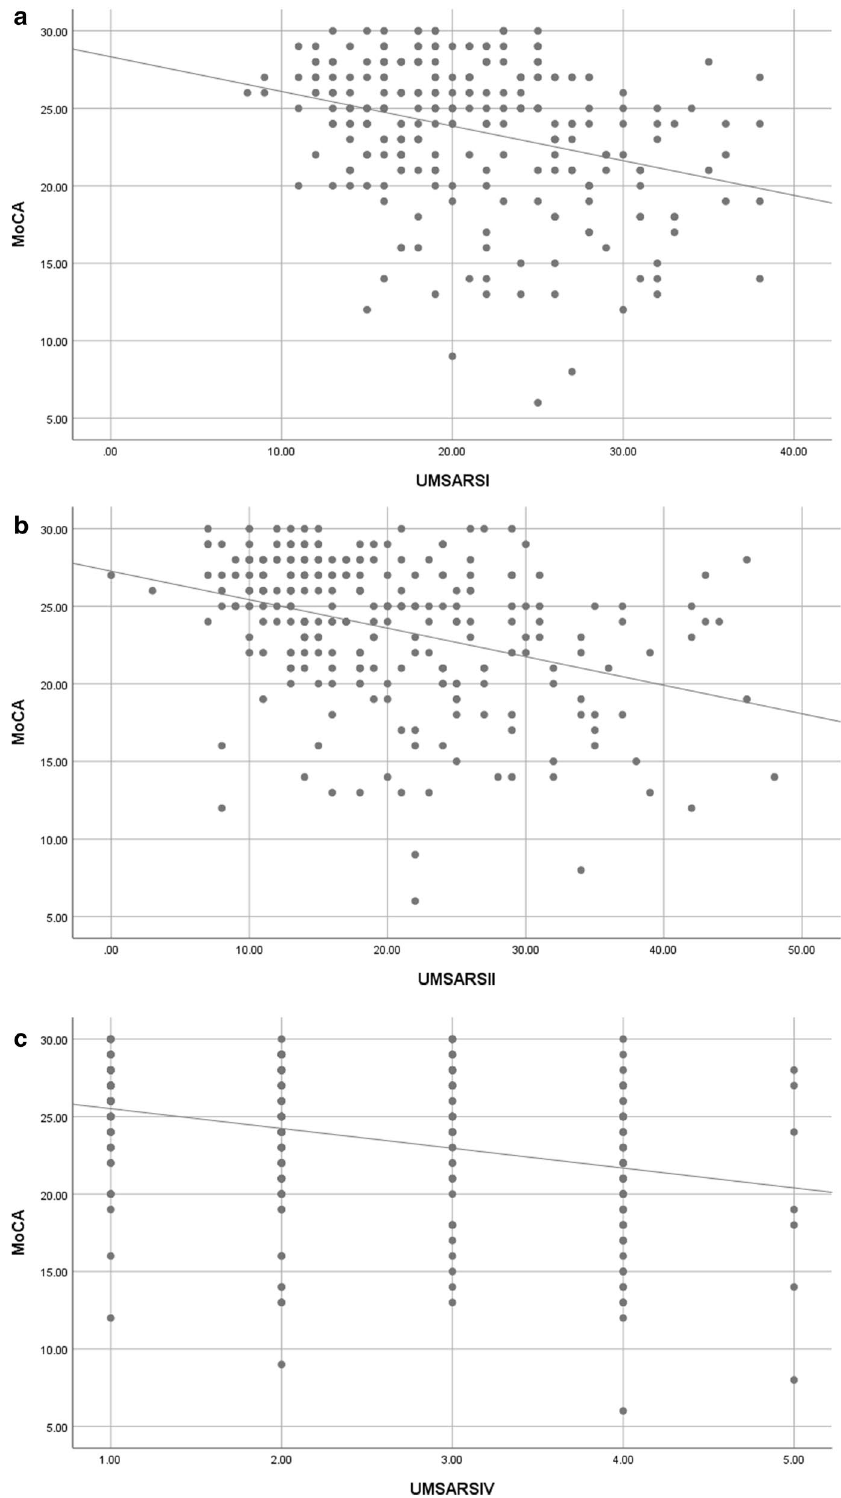
Figure 3. Correlations of total MoCA score with UMSARS I, II, and IV scores in MSA patients. ( A ) UMSARS I score (r = − 0.31, P < 0.01), ( B ) UMSARS II score (r = − 0.36, P < 0.01), ( C ) UMSARS IV score (r = − 0.32, P < 0.01) were negatively correlated with total MoCA score, which suggests a possible correlation between the severity of the disease and degree of cognitive